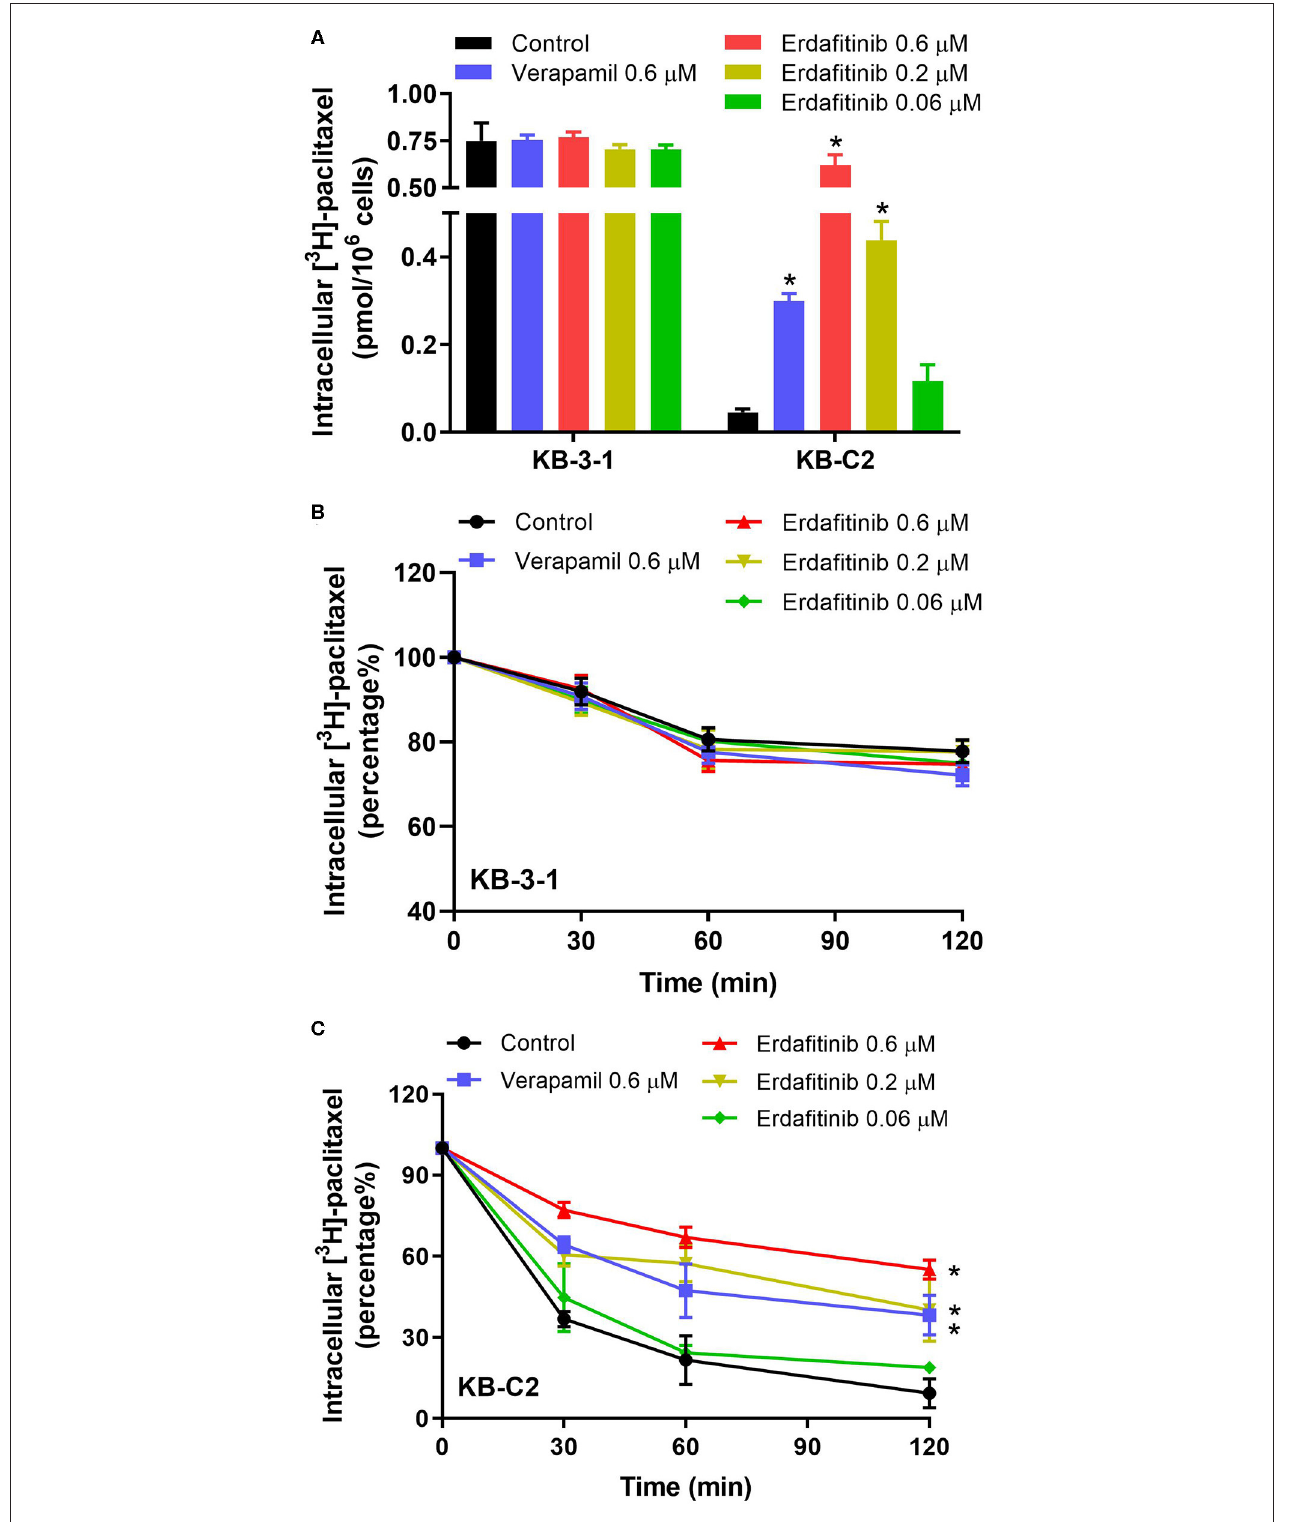
FIGURE 3 | The effect of erdafitinib on the accumulation and efflux of [ 3 H]-paclitaxel in KB-3-1 and KB-C2 cells. (A) The effect of erdafitinib on the accumulation of [ 3 H]-paclitaxel in KB-3-1 and KB-C2 cells. (B) The effect of erdafitinib on the efflux of [ 3 H]-paclitaxel in KB-3-1 cells. (C) The effect of erdafitinib on the efflux of [ 3 H]-paclitaxel in KB-C2 cells. The results are representative of three independent experiments. Error bars indicate SD. * P < 0.05 vs. control. Positive control: the group of verapamil 0.6 µ M.